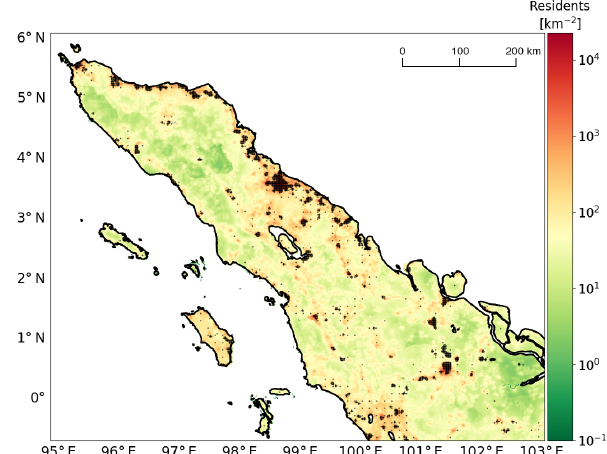
Figure 1. An example of a weighted grid used as an insurance density proxy for the location uncertainty framework. The map shows northern Sumatra. Color indicates population density (resi- dents per square kilometer) as a proxy for insured exposure density. Black markers depict grid points of the weighted grid. The popu- lation data in this plot are based on a free dataset (Gaughan et al.,